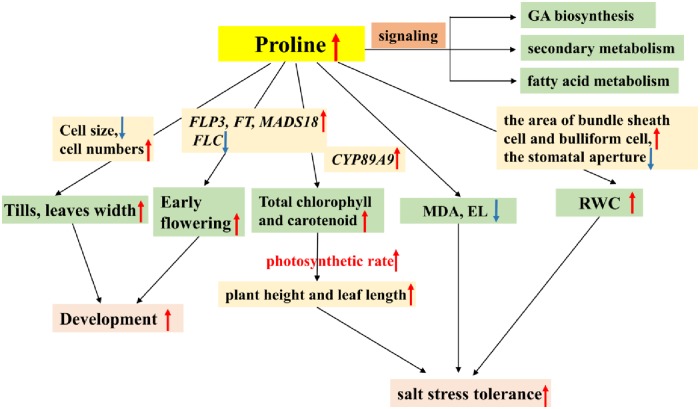
Proline coordinated events and pathways to regulate plant growth and development and salt stress tolerance.